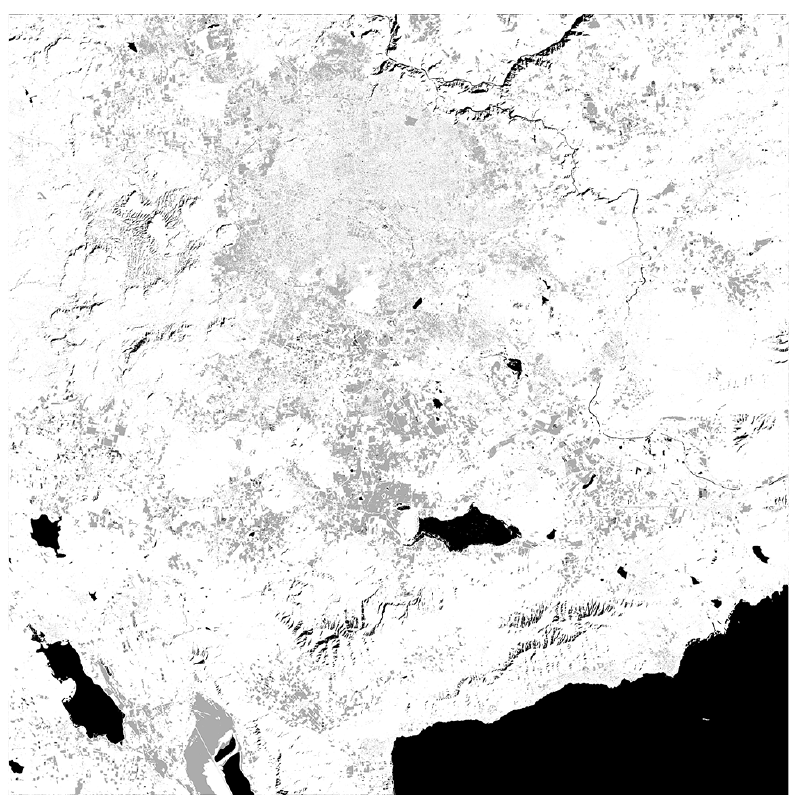
Figure 3. Classification results of the MRS image using the SEC